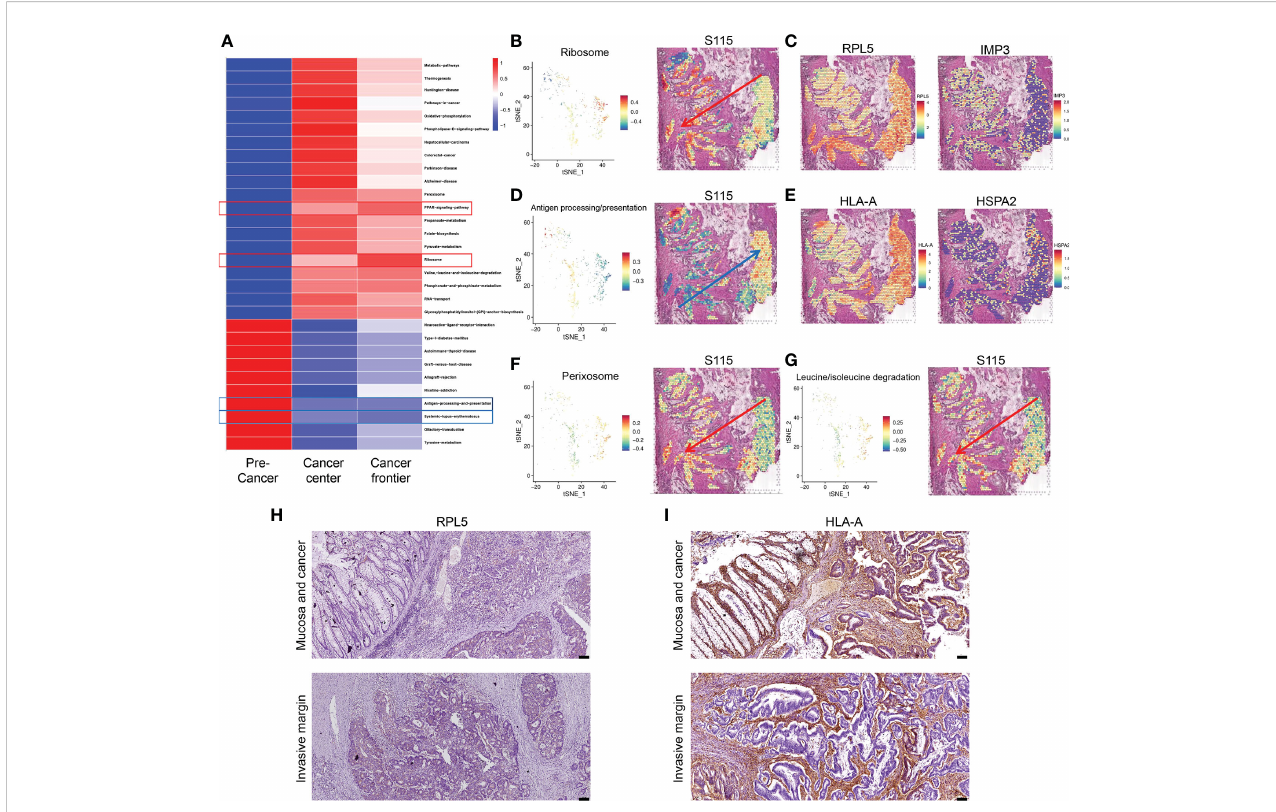
FIGURE 4 Signaling pathways and genes altered in CRC progression. (A) Changes in signaling pathways as CRC developed in sample S115 by GSVA analysis. (B) Spatial distribution and expression trend of ribosome pathway in S115. (C) RPL5 (left) and IMP3 (right) expression gradually increased in the direction of the red arrow. (D) Spatial distribution and expression trend of antigen processing and presentation pathway in S115. (E) HLA-A (left) and HSPA2 (right) expression gradually increased in the direction of the blue arrow. (F, G) Expression direction of peroxisome pathway (F) and leucine and isoleucine degradation pathway (G) in S115. (H, I) Immunohistochemical staining showed expression of RPL5 (H) and HLA-A (I) in Mucosa and cancer(up) and Invasive margin(down) (n=45). The scale bars on the lower right in (H) , (I) are 100